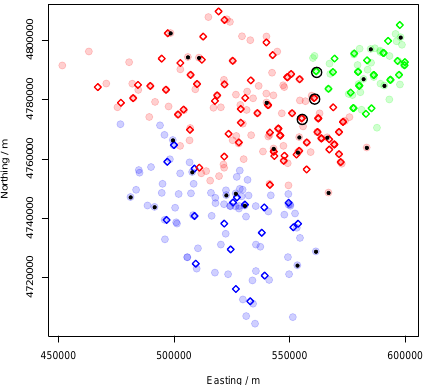
Fig. 1. Locations of gauges used in the study (taken from the three homogeneous regions (Cowpertwait, 2011)): hourly data ( (cid:5) ), daily data (lightly shaded), temperature data ( • ) and gauges used to cali- brate the TETIS catchment model ( (cid:13)